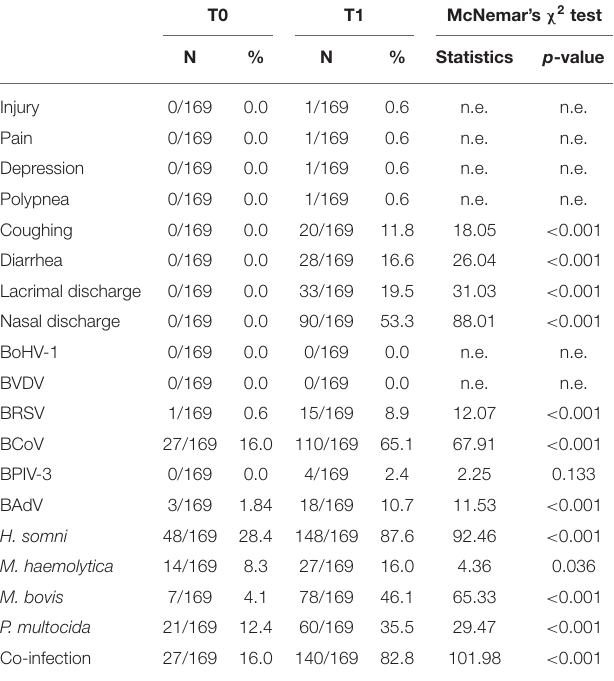
TABLE 3 | Beef steers ( n = 169) traveling from France to Italy. T0 T1